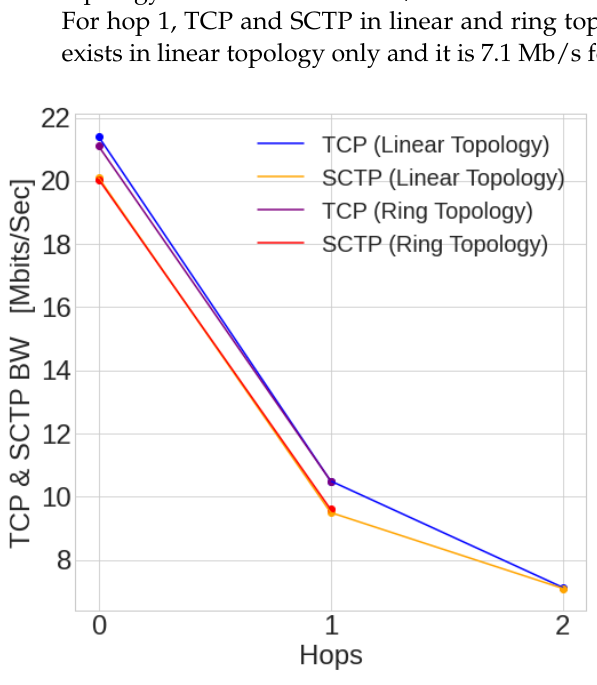
Figure 32. CityLab TCP and SCTP